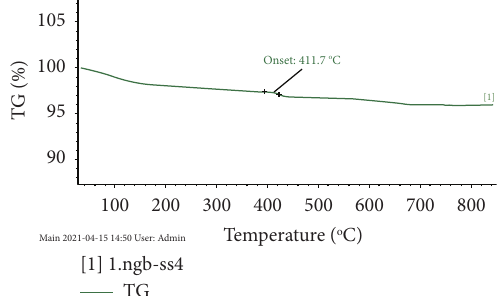
Figure 13: : Mix 2 thermogravimetric analysis (TGA).